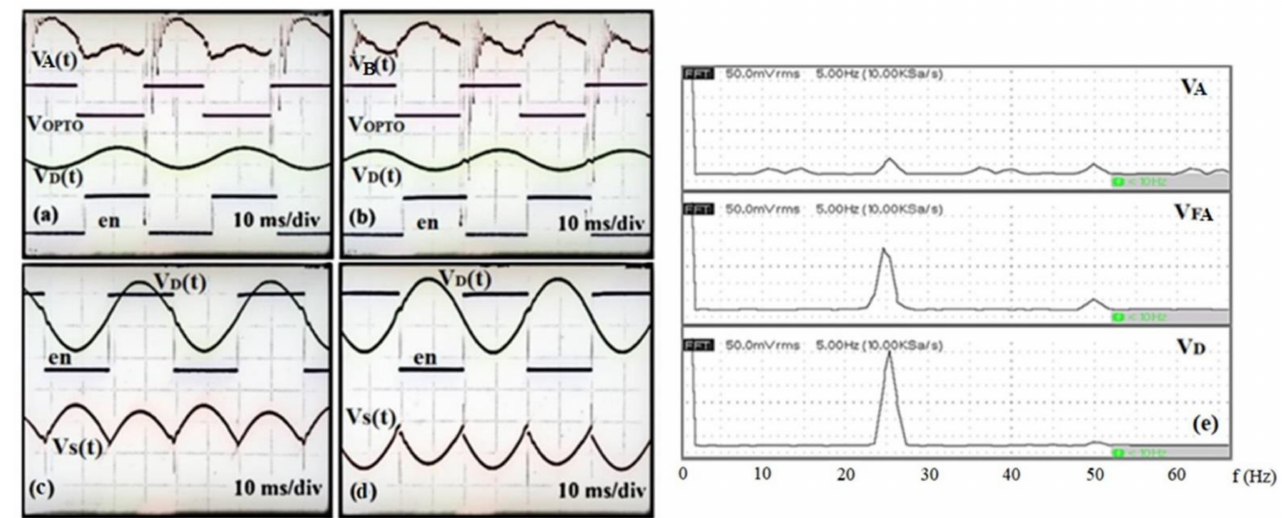
Figure 6. ( a – d ) Oscilloscope measurements; ( e ) amplitude-frequency response characteristics analysis (Hanning window function).